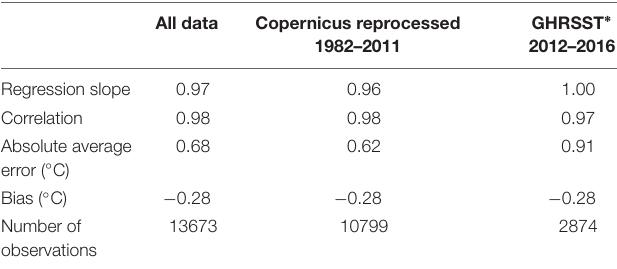
TABLE 1 | Regression, correlation, absolute average error ( ◦ C), and bias ( ◦ C) between in situ measurements and satellite-derived SST ( ◦